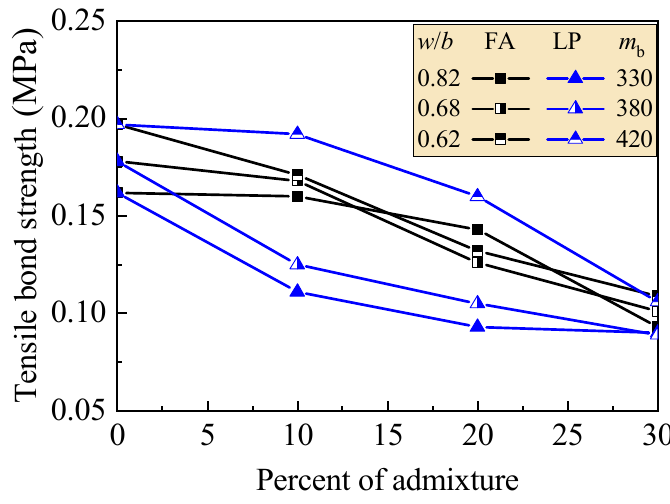
Figure 5. Test results of the tensile adhesive strength of mortars.